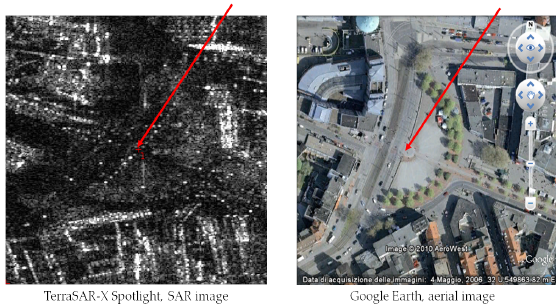
Figure 3: Example of situations faced with during point selection on radar